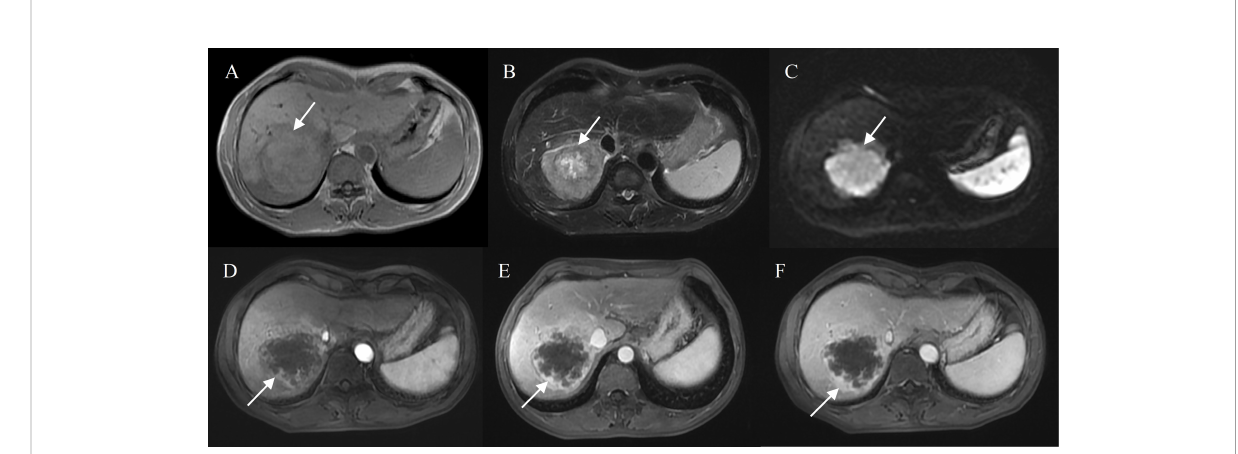
FIGURE 2 Hepatocellular carcinoma with peripheral rim enhancement in a 60-year-old male without chronic viral hepatitis. Gd-DTPA-enhanced MRI detected a round and non-smooth tumor (10.2 cm) with heterogeneous SI on T1WI and T2WI (A, B) , restricted diffusion (C) . Peripheral rim-like enhancement in the arterial phase (D) and sustained rim enhancement in the portal and delayed phase (E, F) . Incomplete capsule enhancement on portal venous phase (E) and delayed phase images (F)